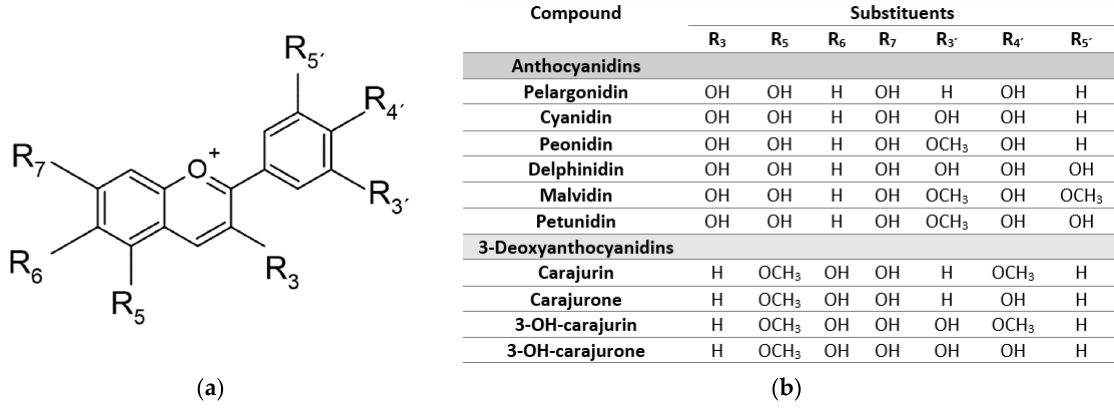
Figure 1. Chemical structure of anthocyanidins ( a ) for the six major types found in nature and the less common 3-deoxyanthocyanidins (3D-anth) ( b ).